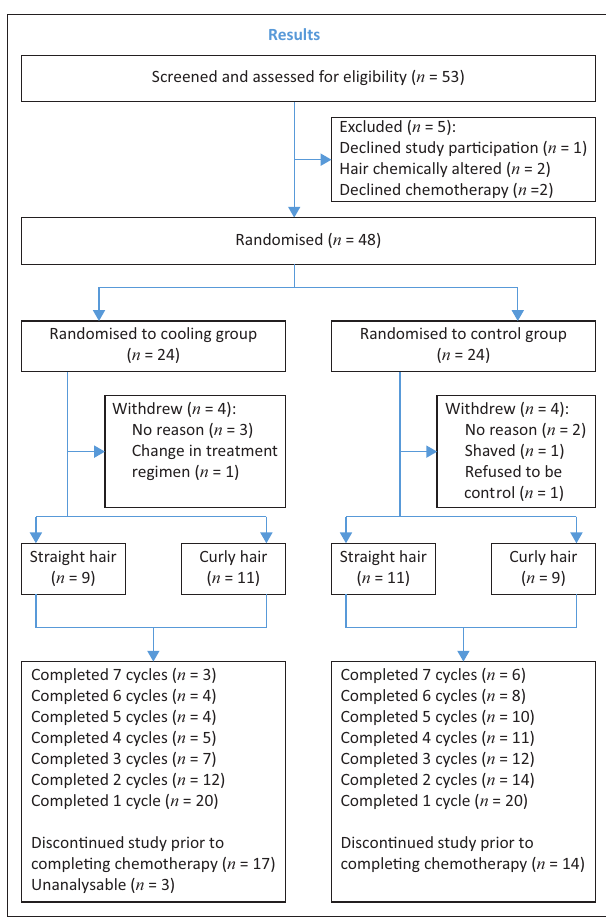
FIGURE 1: Flow diagram of progress through phases of pilot